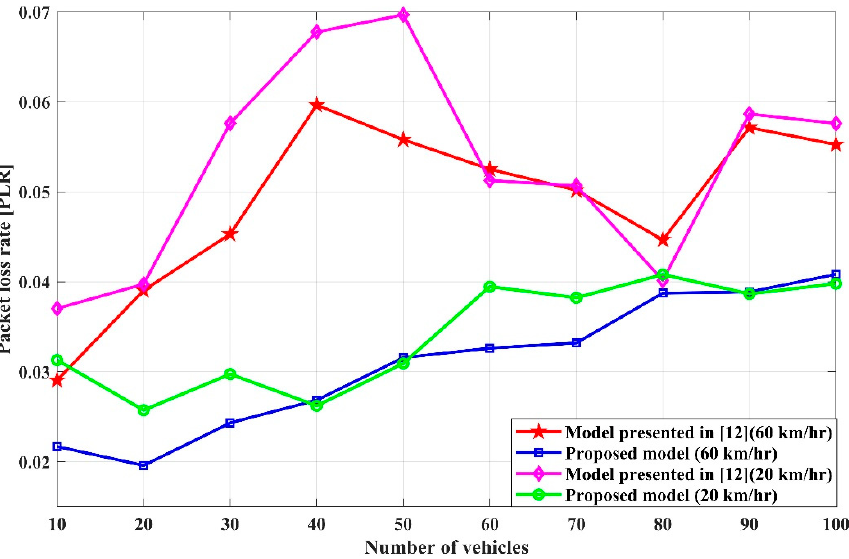
Figure 10. Packet loss rate (PLR) vs. number of vehicles.